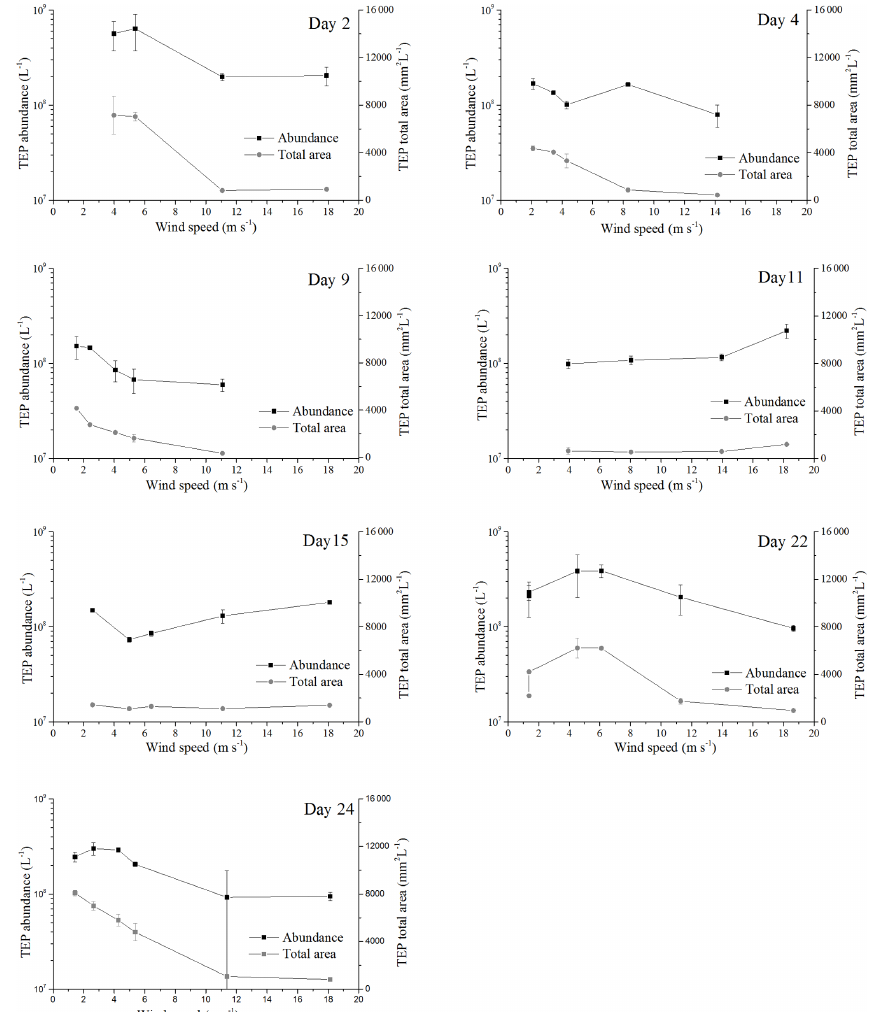
Figure 2. Response of abundance and total area for TEP SML to increasing wind speeds; the error bars indicate ±